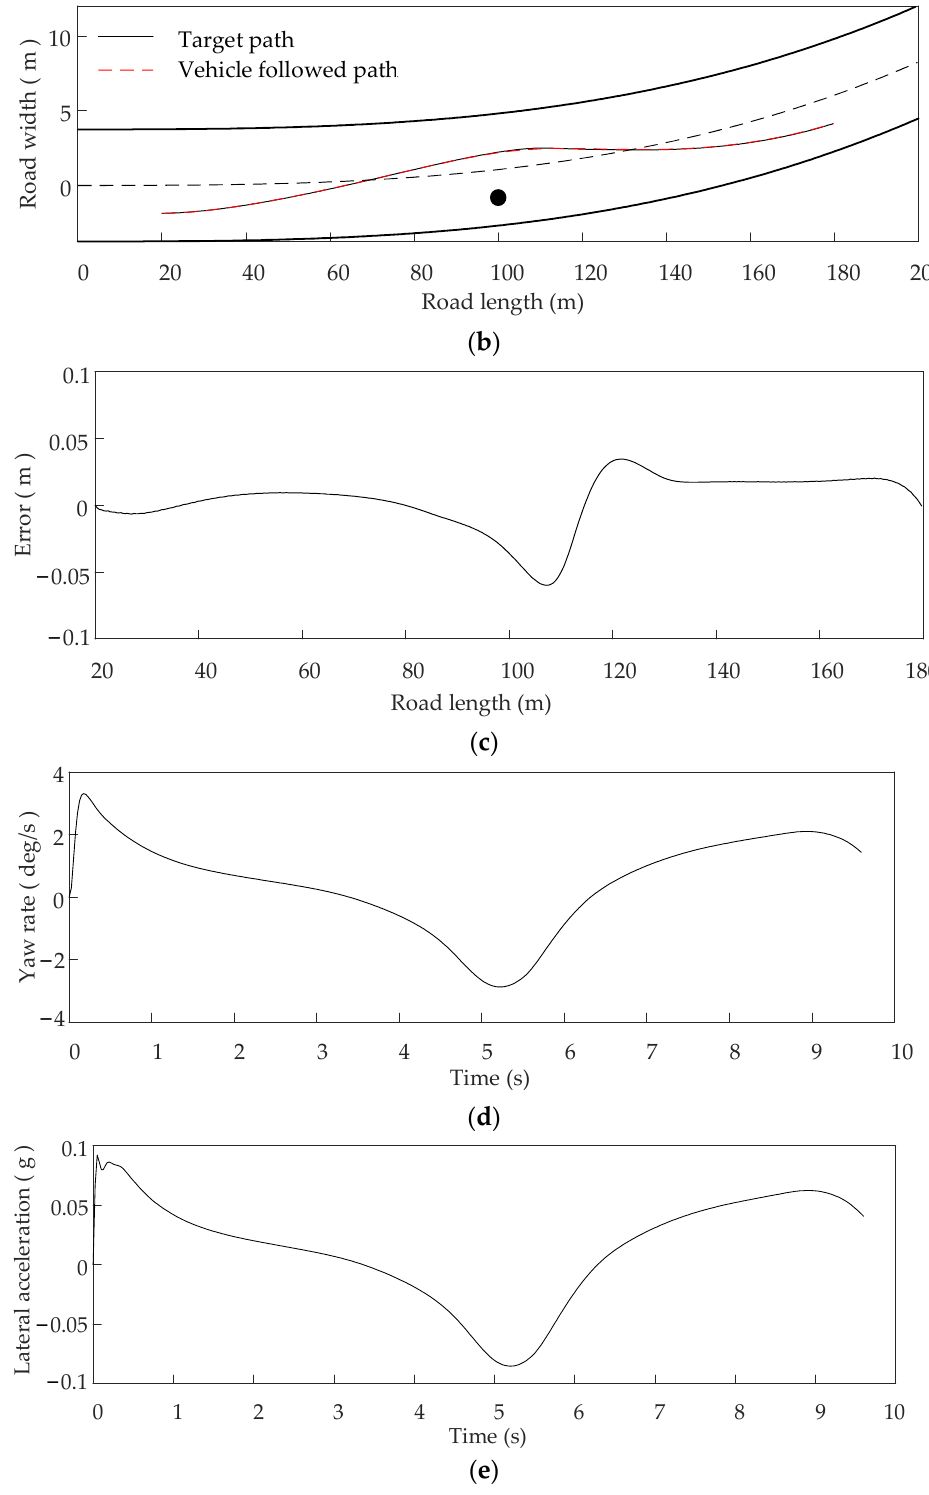
Figure 12. Path tracking results in curved road environment. ( a ) Planned path on curved road. ( b ) Path following result on curved road. ( c ) Path following error on curved road. ( d ) Yaw velocity on curved road. ( e ) Lateral acceleration on curved road.